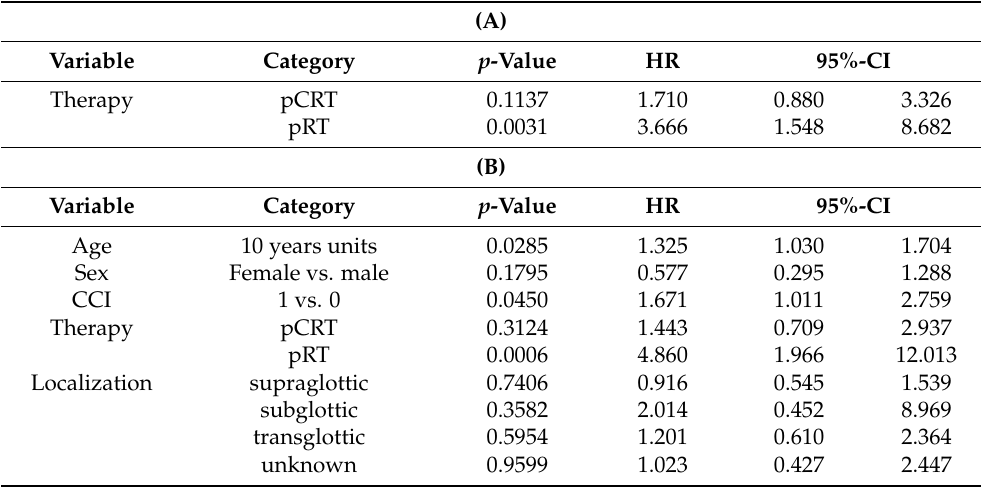
Table 4. ( A ) Univariable Cox regression analysis of OS in stage III; ( B ) Multivariable Cox regression analysis of OS in stage III; ( C ) Univariable Cox regression analysis of OS in T3; ( D ) Multivariable Cox regression analysis of OS in